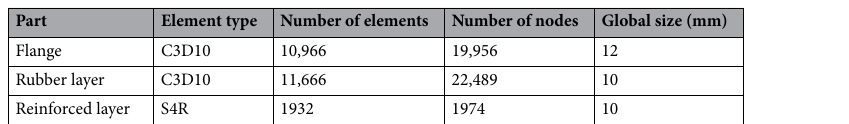
Table 2. Mesh information of the finite element